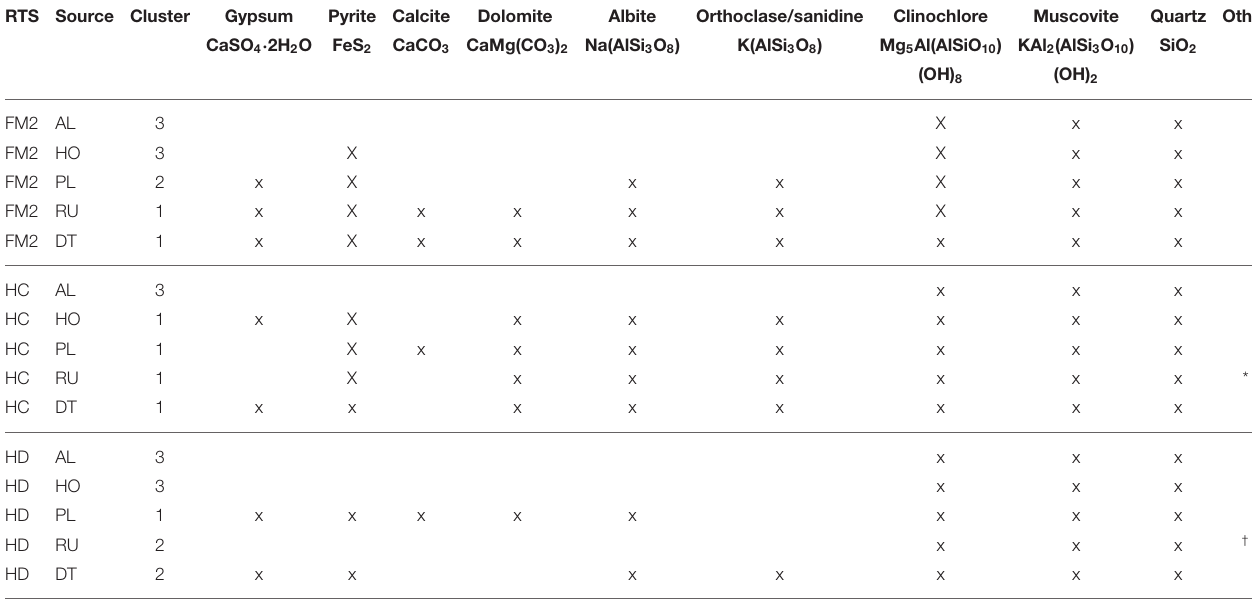
TABLE 2 | Minerals detected by X-ray diffraction (x) in non-sterilized sediments. RTS Source Cluster